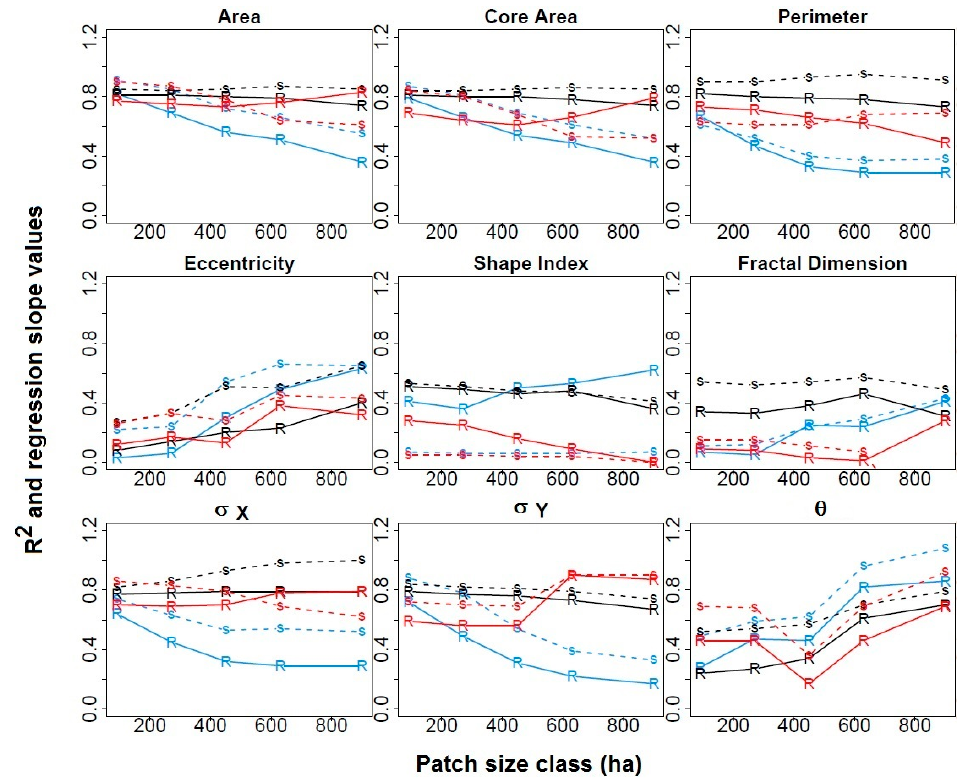
Figure 6. Coefficient of determination (R—Lines) and slope (S—Dashed lines) obtained for each fire patch metric (Area, Core Area, Perimeter, Shape Index, Fractal Dimension and Eccentricity, X and Y ellipse axis σ x and σ y , azimuthal direction θ angle of the longest axis of the ellipse) regressions by patch size classes (X axis, patch minimum surface in ha ), for comparisons of LANDSAT × MCD45A1 (blue), MCD45A1 × ESA FIRE_CCI (black) and LANDSAT × ESA FIRE_CCI (red).